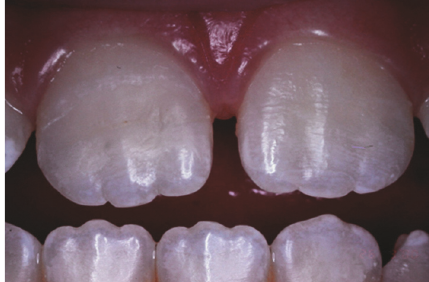
Figure 3: Clinical aspect of the original reattached tooth fragment.